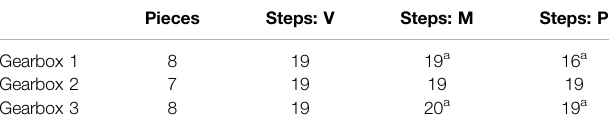
TABLE 2 | The numbers of components and assembly